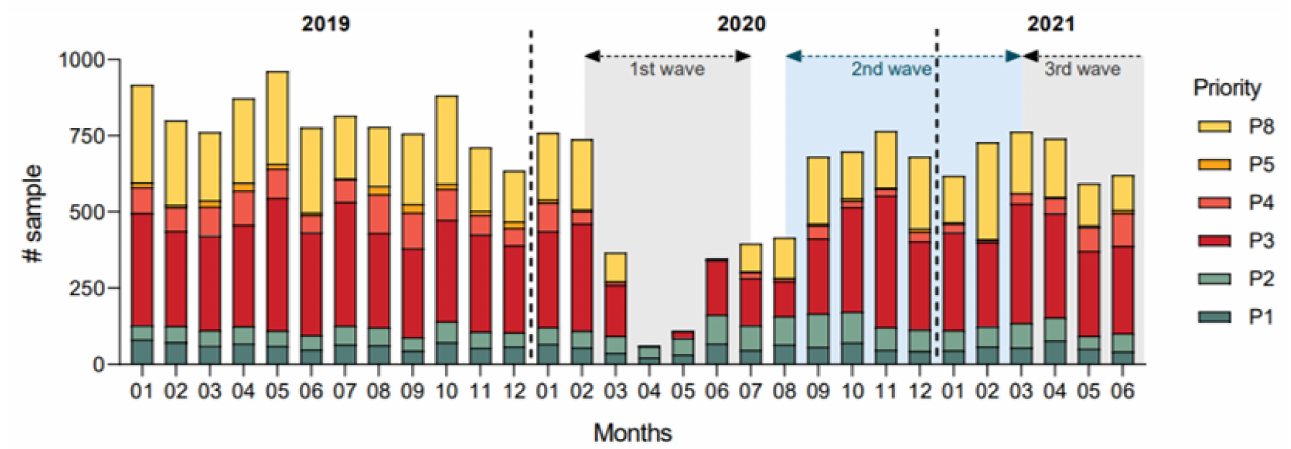
Figure 2. Colonoscopies performed at the CHUM per month with waves of the COVID-19 pandemic in Quebec, Canada. Waves of the pandemic in Quebec: 1st wave from 25 February 2020, to 11 July 2020; 2nd wave from 23 August 2020, to 20 March 2021; and 3rd wave from 21 March 2021, to 17 July 2021 [15].